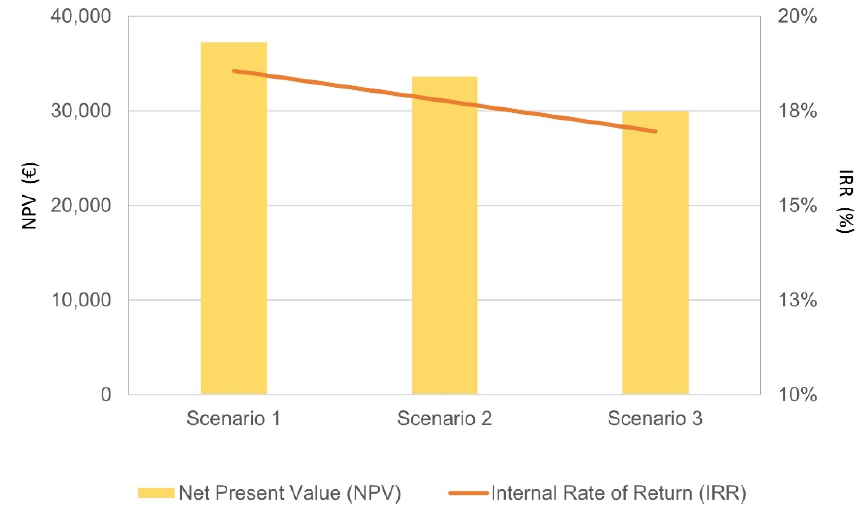
Figure 12. Basis of the economic summary as approach.